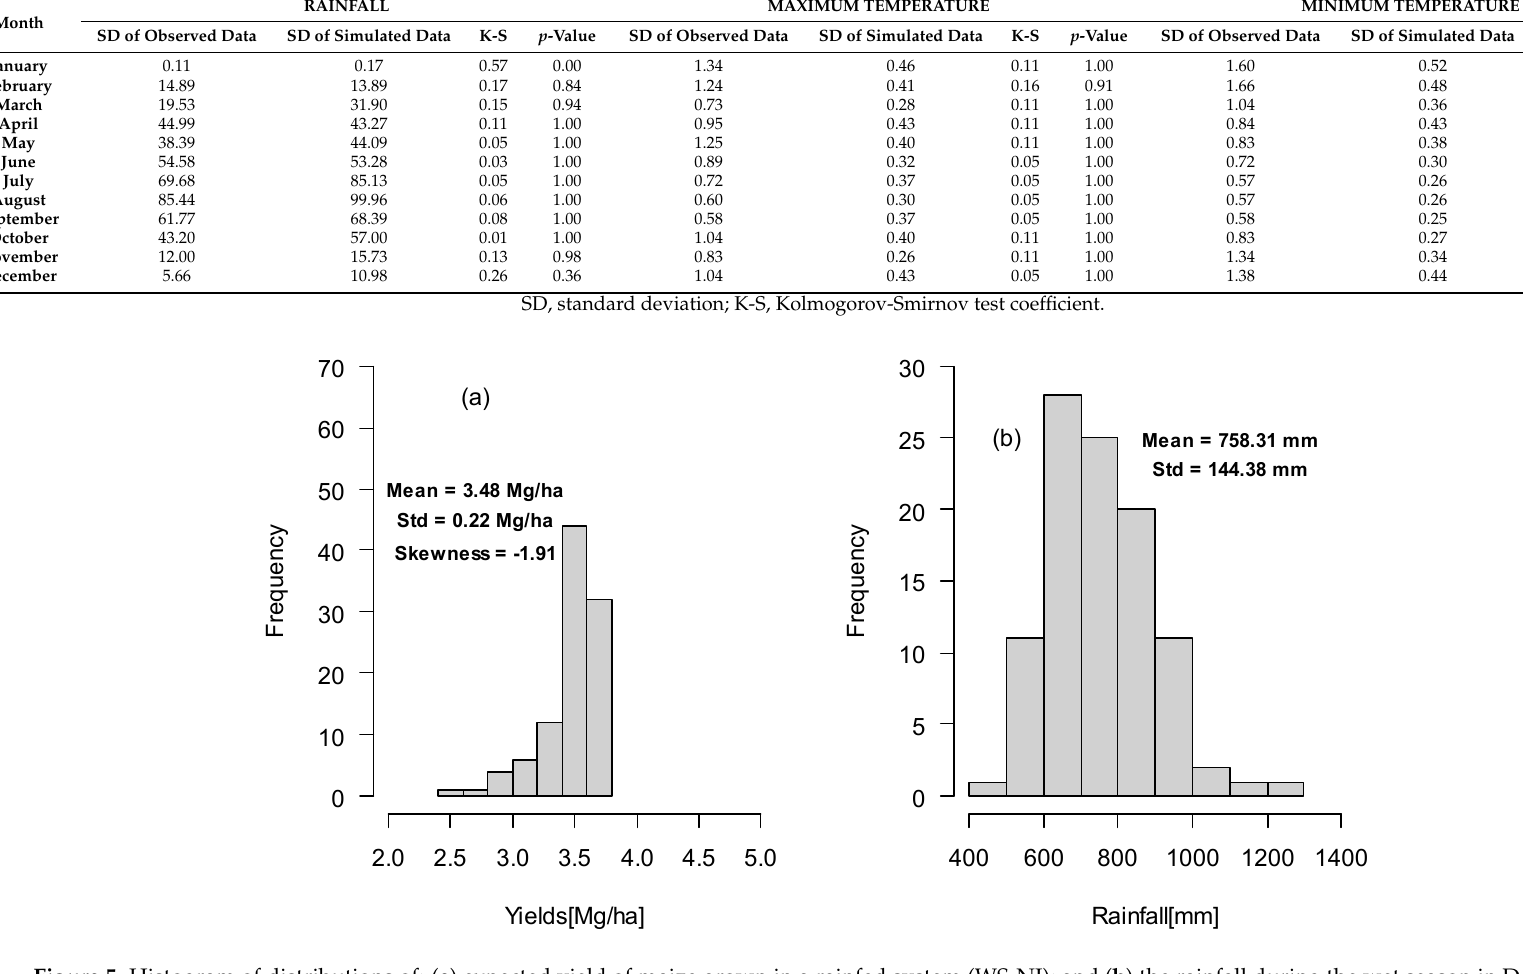
Figure 5. Histogram of distributions of: ( a ) expected yield of maize grown in a rainfed system (WS-NI); and ( b ) the rainfall during the wet season in Dapaong.